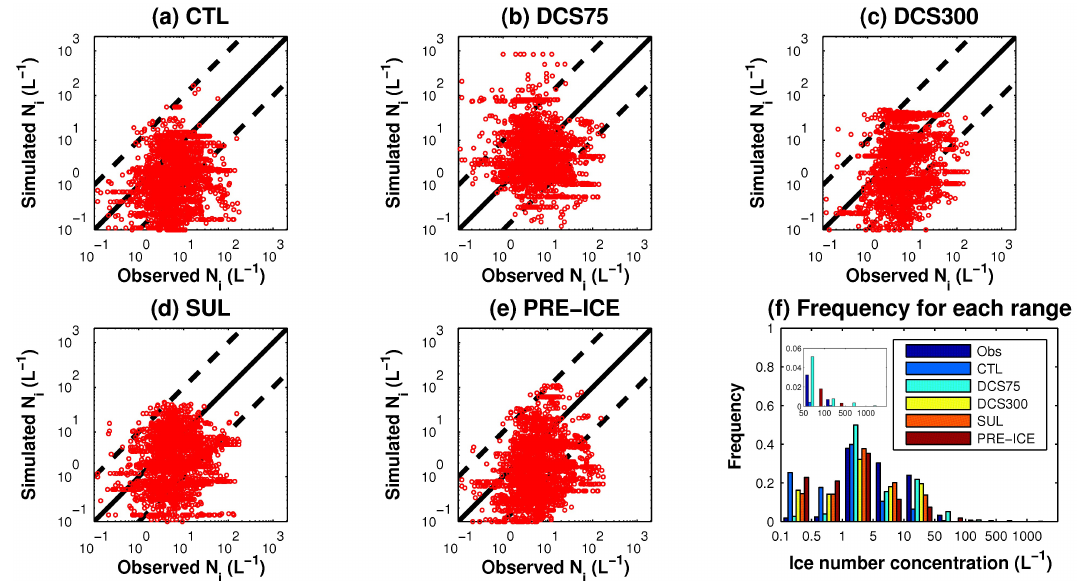
Figure 8. As Fig. 6 but for the number concentrations ( N i ) of ice crystals with diameters larger than 75µm for all the experiments. The inset in (f) is the frequency of N i plotted for N i >50L − 1 . Note that both the comparisons are restricted to the cases when the model captures observed ice clouds ( T ≤ − 40 ◦ C).